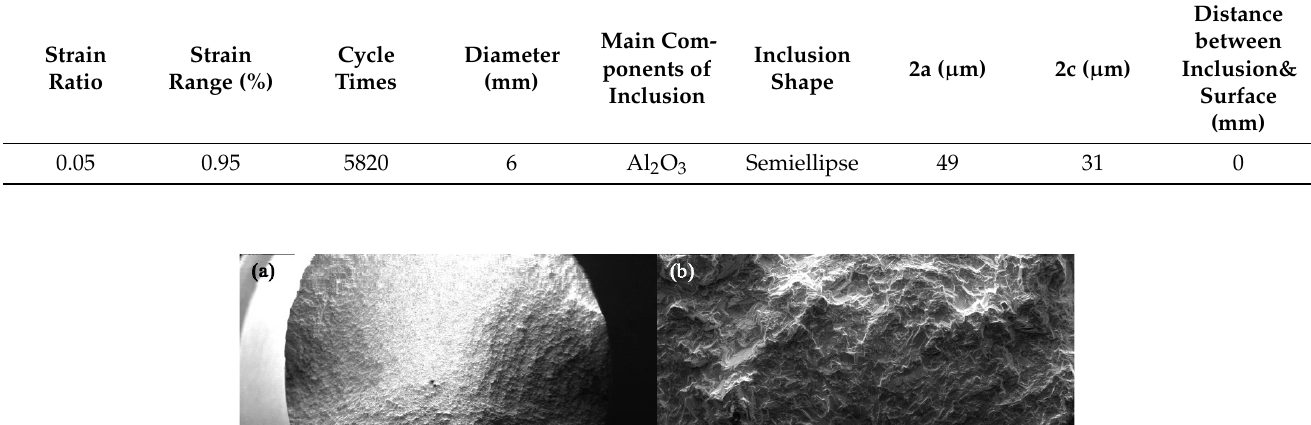
Table 2. Experimental Data of Specimen No. 2.